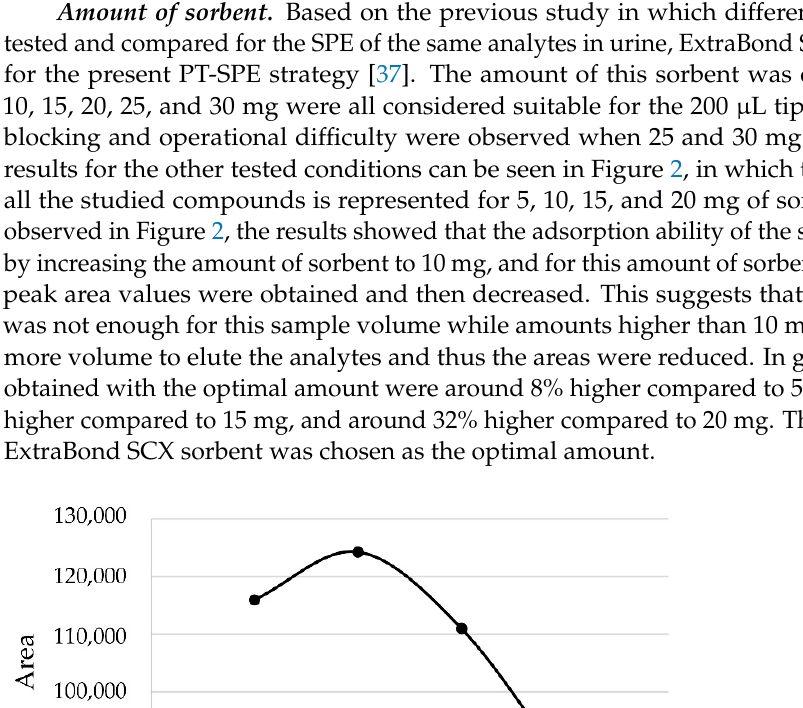
Figure 3. Evaluation of different loading volumes of urine:H 2 O at pH 4 (50:50, v/v ) at a spiked con- centration of 50 ng mL − 1 . Aspirating/dispensing cycles of sample loading volume. The number of aspirat- ing/dispensing cycles of loading volume is of great importance in the PT-SPE technique since the adsorption of the analytes may vary after some cycles and there is no agreement about this issue in the literature, as was mentioned in the Introduction [27,28,30,32–34]. For this reason, one, two, and three aspirating/dispensing cycles of the sample loading 01020 30 40